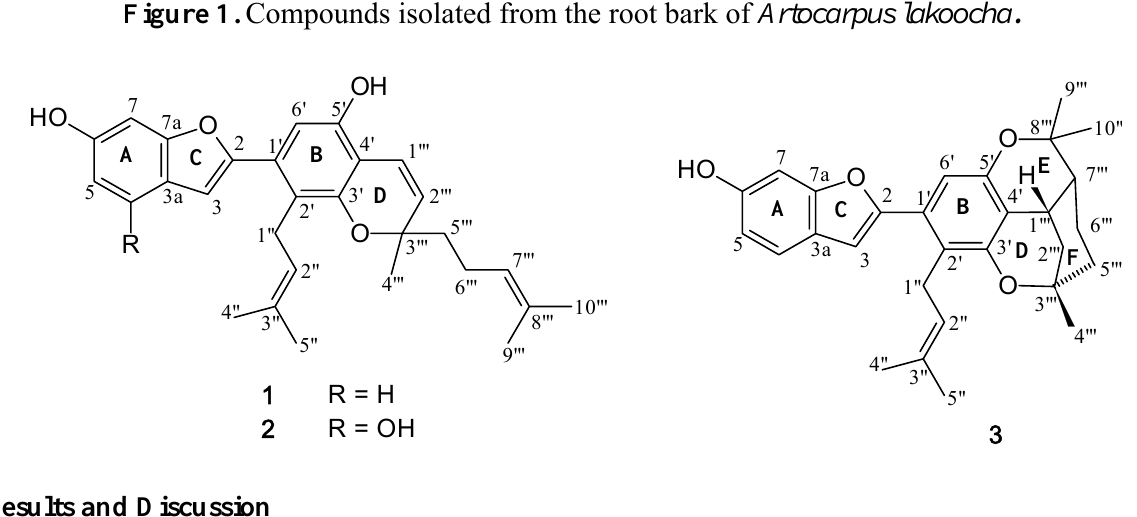
Figure 1. Compounds isolated from the root bark of Artocarpus lakoocha.